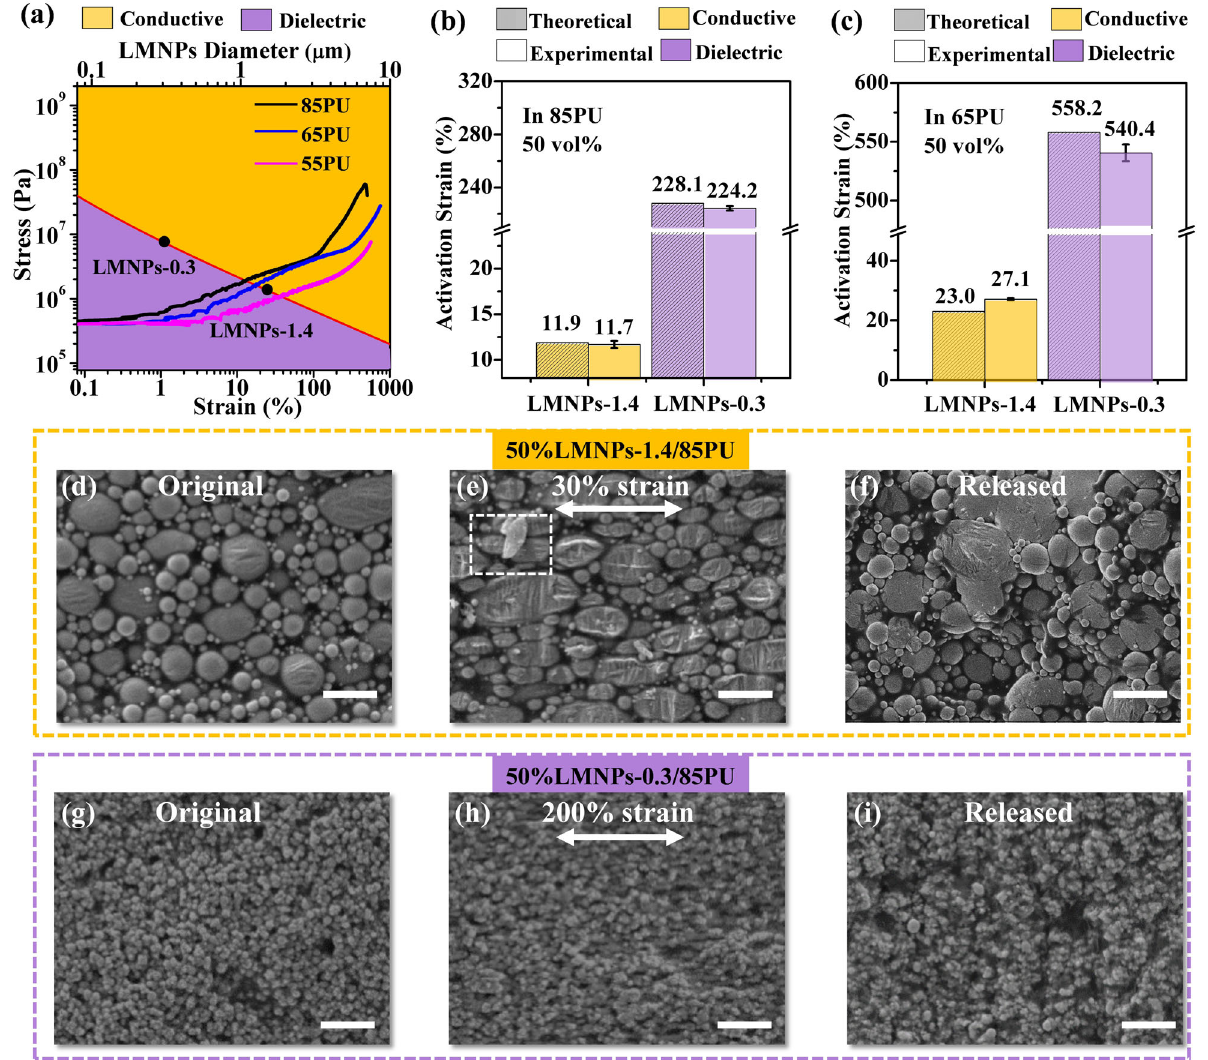
Fig. 2 Veri fi cation of calculated results. a Stress – strain curves of various PU coupled with calculated LMNPs activation stress. Theoretical and experimental activation strain of b 50%LMNPs-1.4/85PU and 50%LMNPs-0.3/85PU and c 50%LMNPs-1.4/65PU and 50%LMNPs-0.3/65PU. The error bars show the standard deviation. Top view SEM images of 50%LMNPs-1.4/85PU under d original state, e 30% strain, and f relaxed state and 50%LMNPs-0.3/85PU under g original state, h 200% strain, and i relaxed state. Out fl owed EGaIn is emphasized in white box with dashed lines of e . The scale bars in d – i are 4 μ